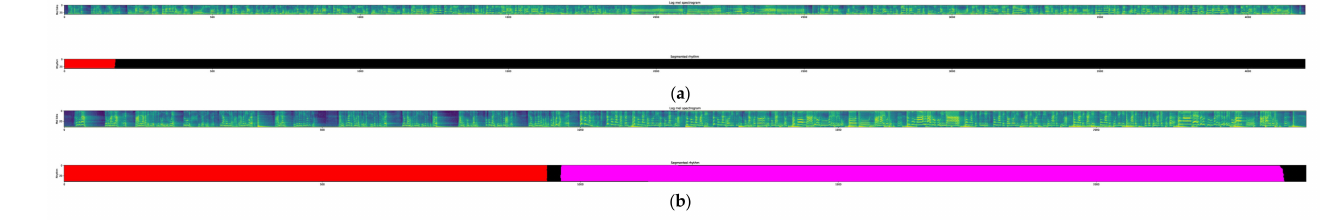
Figure 5. Pixel-level segmentation results of test samples using DeepLabV3+. The best segmen- tation network distinguishes the musical modes with unique color per class. The background class is illustrated with black (RGB: 0, 0, 0), Aniri with red (RGB: 255, 0, 0), AniriChangzo with green (RGB: 0, 255, 0), Jajinmori with blue (RGB: 0, 0, 255), Jinyangjo with yellow (RGB: 255, 255, 0), Jungjungmori with pink (RGB: 255, 0, 255) and Jungmori with sky green (RGB: 0, 128, 128). ( a ) Semantic segmentation result of a test sample using best segmentation network. The upper figure is an input log Mel-spectrogram and the lower figure is the predicted mask (ground truth: Aniri 0 s to 5 s and Utmori 6 s to 191 s). ( b ) Semantic segmentation result of a test sample using best segmentation network. The upper figure is an input log Mel-spectrogram and the lower figure is the predicted mask (ground truth: Aniri 0 to 29 s and Jungjungmori 30 to 75